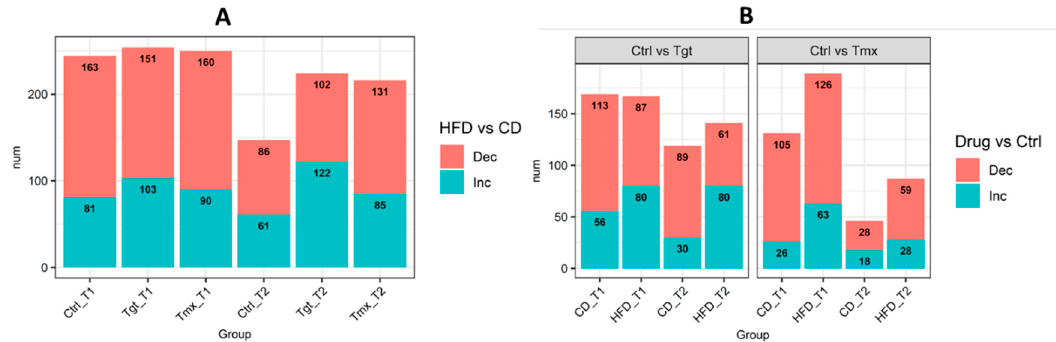
Figure 3. ( A ) Number of metabolites significantly changed in abundance in HFD vs. CD for each group; ( B ) Number of metabolites significantly changed in abundance in Drug vs. Ctrl for each group. Pink shows metabolites decreased and blue shows metabolites increased. Diets: standard diet (CD); high fat diet (HFD) Times: T1, 78 days of age; T2, 190 days of age; Treatments: Ctrl, control; Tgt, targretin; Tmx, tamoxifen.